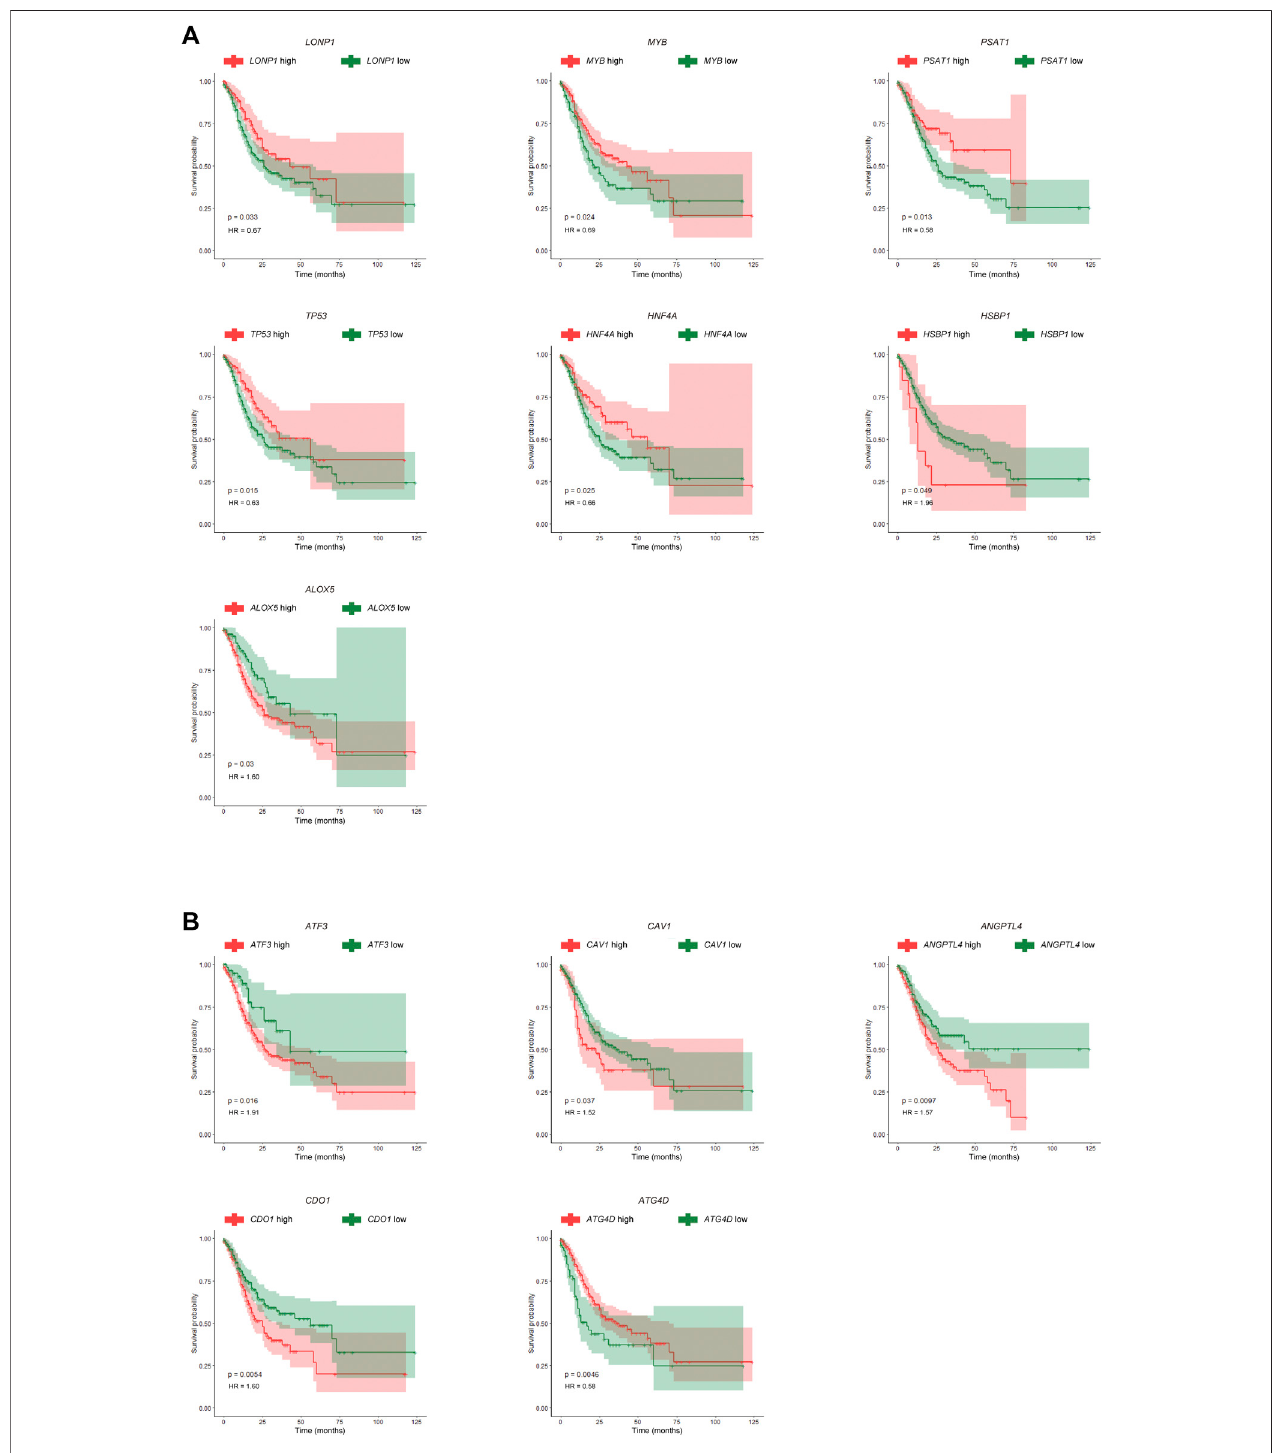
FIGURE 3 | Kaplan-Meier (K-M) survival curves for prognosis-related FRGs in GC. (A) K-M survival curves and p -values for the seven GC-upregulated and prognosis-related FRGs. (B) K-M survival curves and p -values for the fi ve GC-downregulated and prognosis-related FRGs.